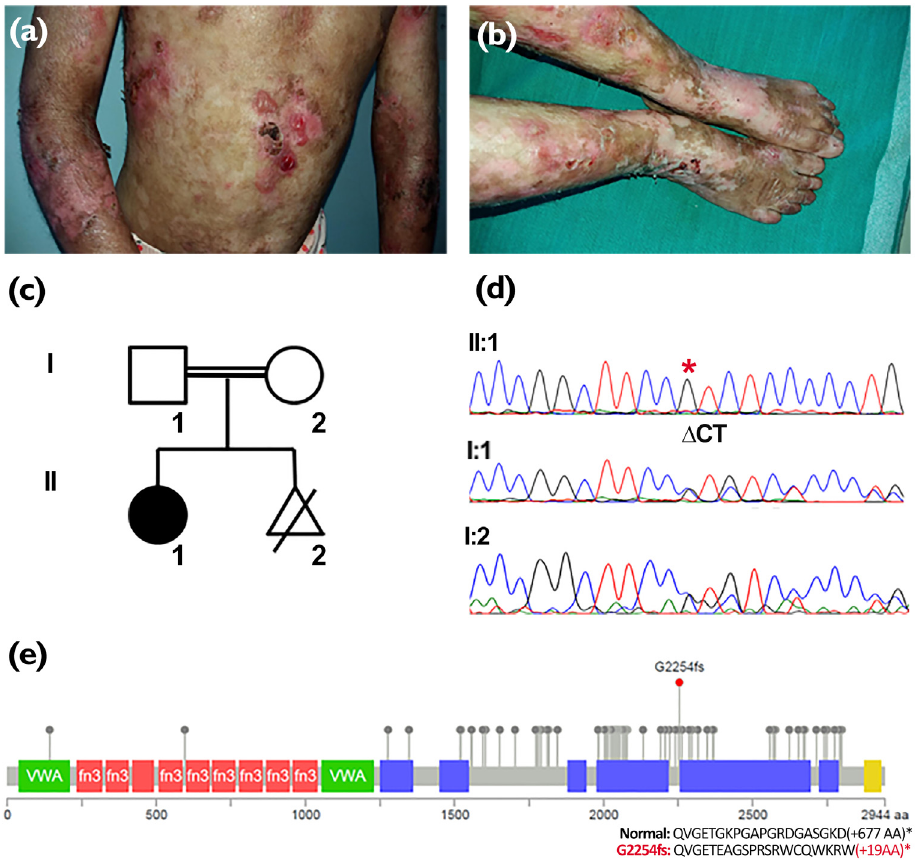
Figure 1. a ) Hands and thoracic region showing generalized bullae, scarring and milia b ) Lower legs showing scarring, bullae, milia and characteristic dystrophic nails c ) Pedigree of the family d ) The chromatogram depicting capillary sequencing results of c.6759_6760del in the trio. The mutation loci ( Δ CT) is highlighted with asterisks e ) Domain structure of COL7A1 protein showing Von Willebrand factor type A domain (VWA), Fibronectin type III domain (fn3), collagen triple helix domain (blue) and Kunitz domain (yellow). Each needle